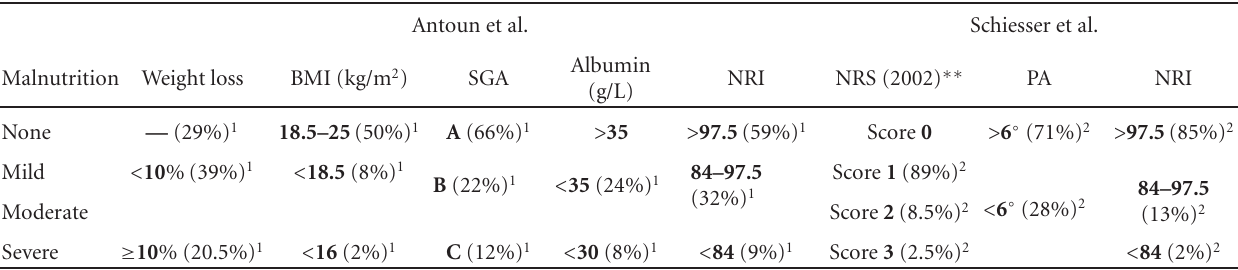
Table 2: Overview on common screening tools for malnutrition and its reported prevalence depending on study and screening tool. Antoun et al. Schiesser et al. Malnutrition Weight